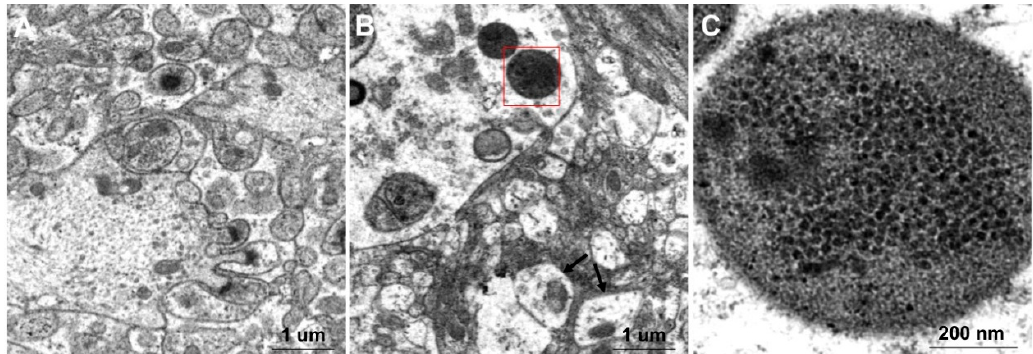
Figure 5. Observation of the negatively stained brain tissues from RGNNV-infected and mock-infected Mandarin fish using electron microscopy. ( A ) Brain tissue of mock-infected mandarin fish; ( B ) Brain tissue of RGNNV-infected mandarin fish. Black arrows indicate that mitochondria are swollen; ( C ) Enlarged view from ( B ) shows that a lot of closely arranged particles were enclosed in the inclusion body.